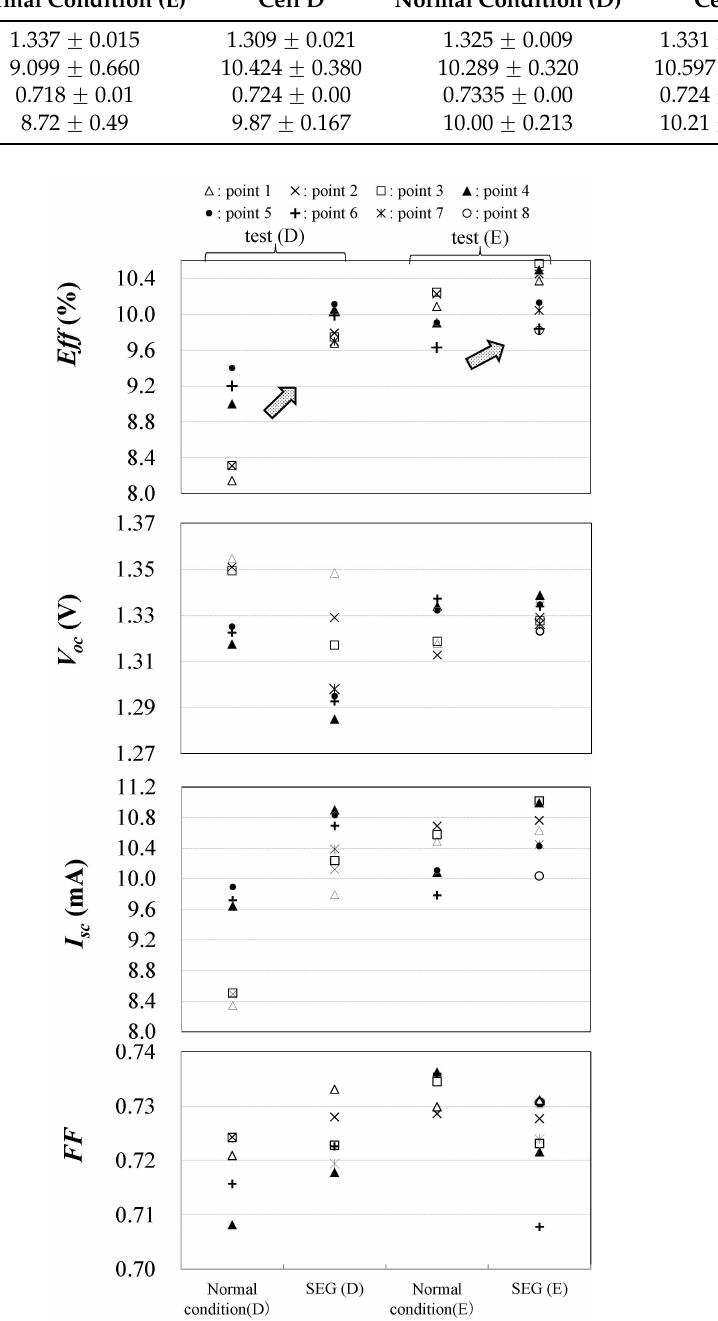
Figure 3. Results of each test cell: cell D, cell E, normal-condition cell D, and normal-condition cell E. For each cell type, eight cells were fabricated. Points 1-8 were cells location of